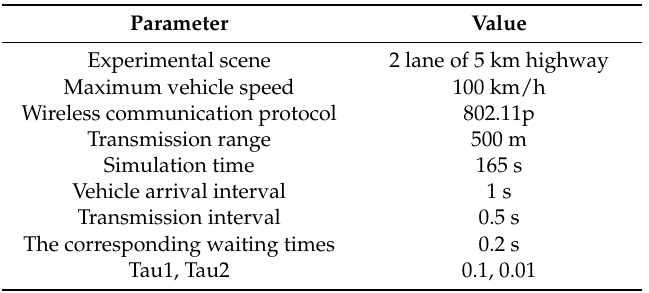
Table 2. Parameter setting.